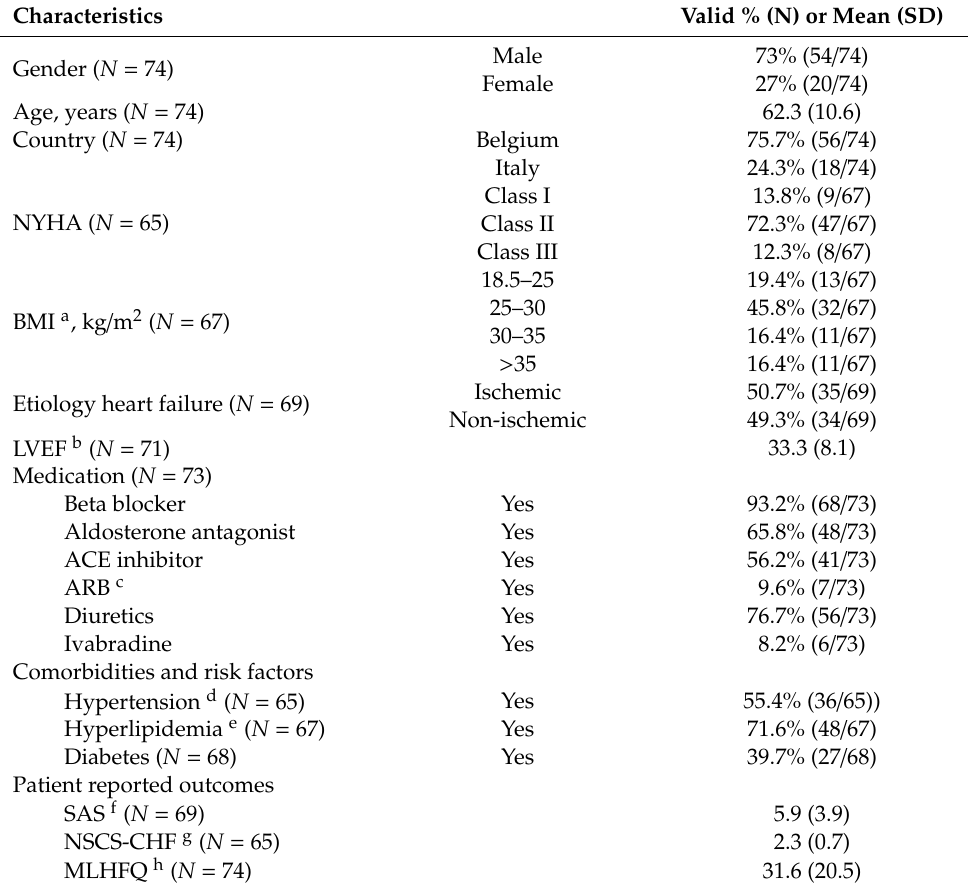
Table 1. Sample size